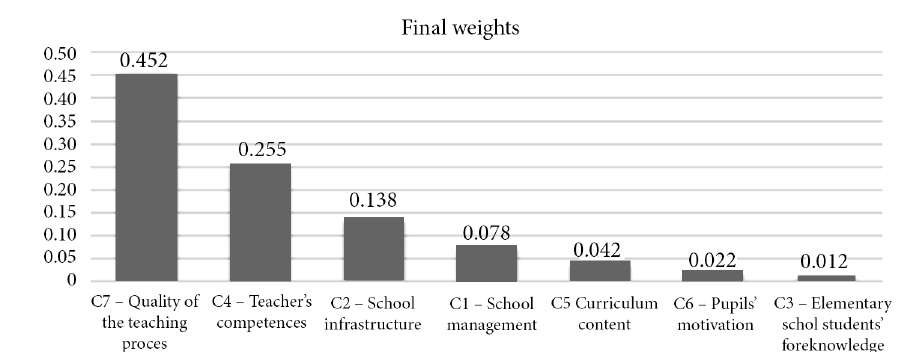
Figure 2. Final weighting coefficients obtained using the fuzzy